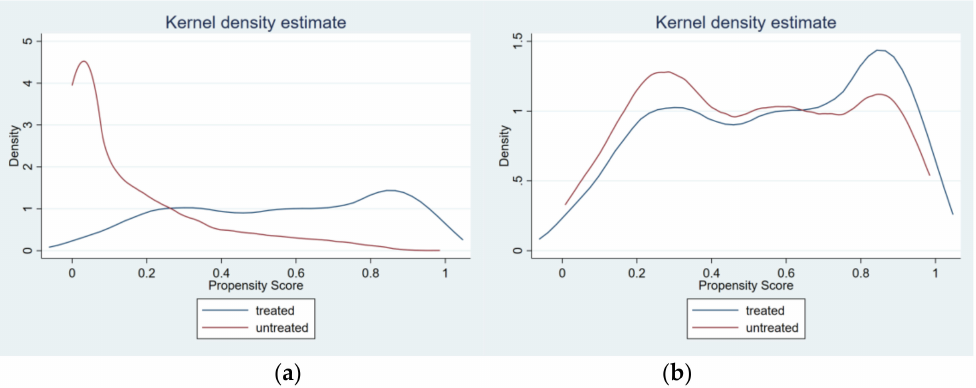
Figure 4. ( a ) Kernel density of Propensity Score before matching; ( b ) Kernel density of Propensity Score after